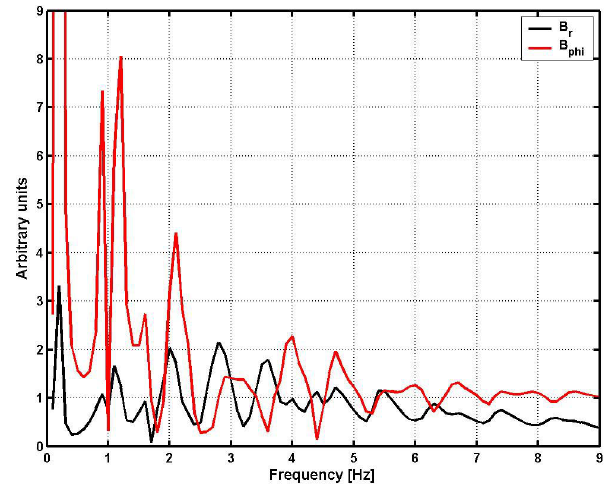
Fig. 1. A theoretical power spectrum in arbitrary units of the transverse B φ , and longitudinal B r , magnetic field components of an electromagnetic wave (emitted from a single, vertical electric dipole) propagating in the Earth-ionosphere waveguide, as observed at NL ( θ =19 ◦ ) , at 18:00UT on 10 September 2005, assuming a wave angel φ =0 ◦ and an IRI ionosphere height profile. The har- monic structure seen in both components is a manifestation of a standing wave in the IAR cavity producing a periodicity in the wave guide upper boundary impedance.